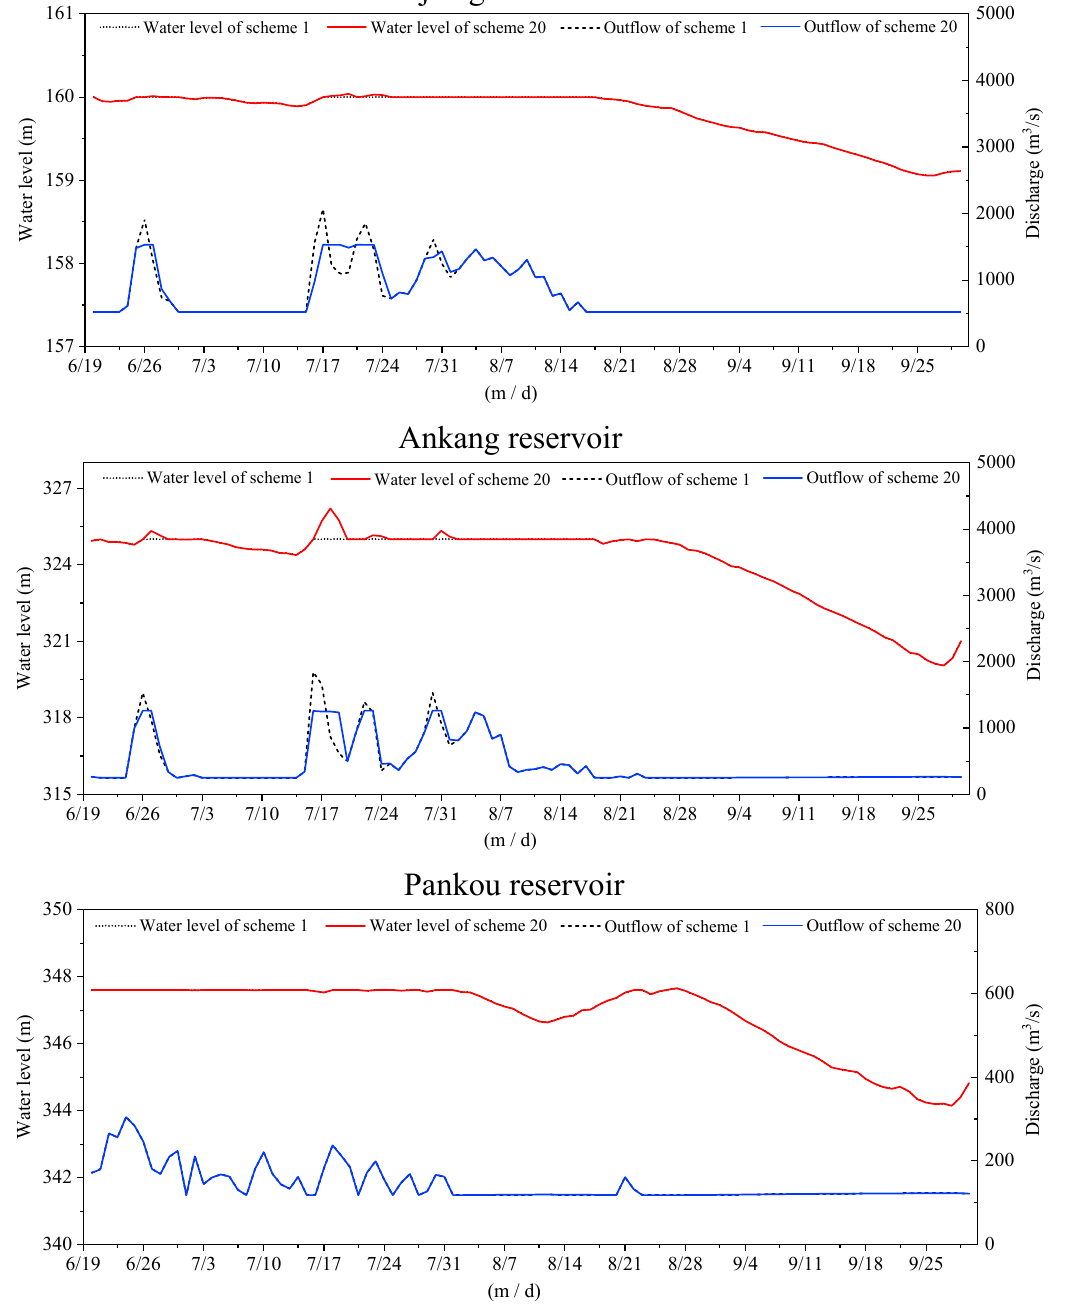
Figure 6. Comparison of operation process between scheme 1 and scheme 20 in a dry year.